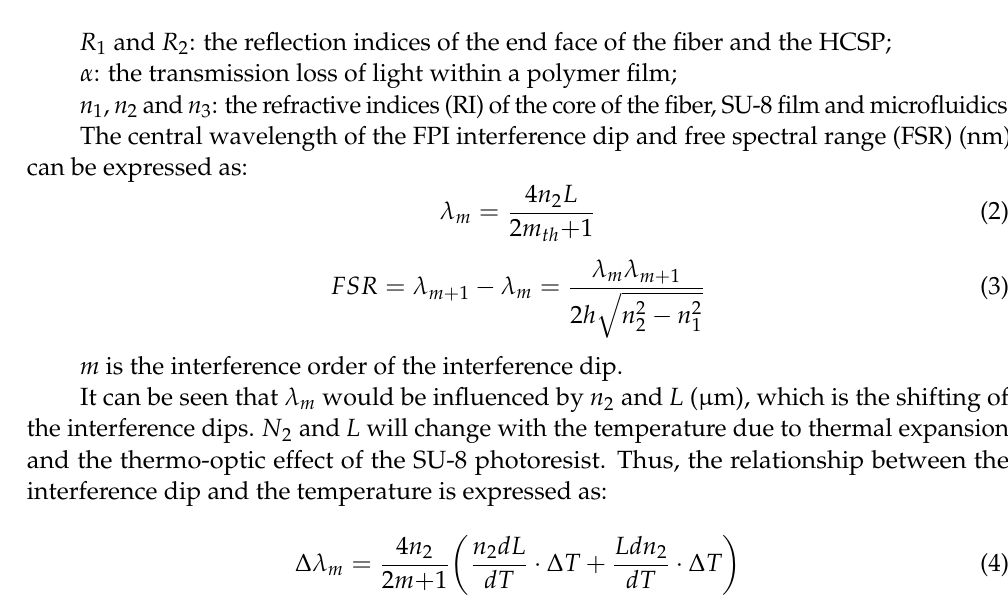
Figure 2. ( a ) Schematic diagram of the microfluidic chip design. ( b ) Optical fibers inserted in the fiber channels at the cross section. ( c ) Principle of light field interference of HCSP. M1: mirror 1, M2: mirror 2.